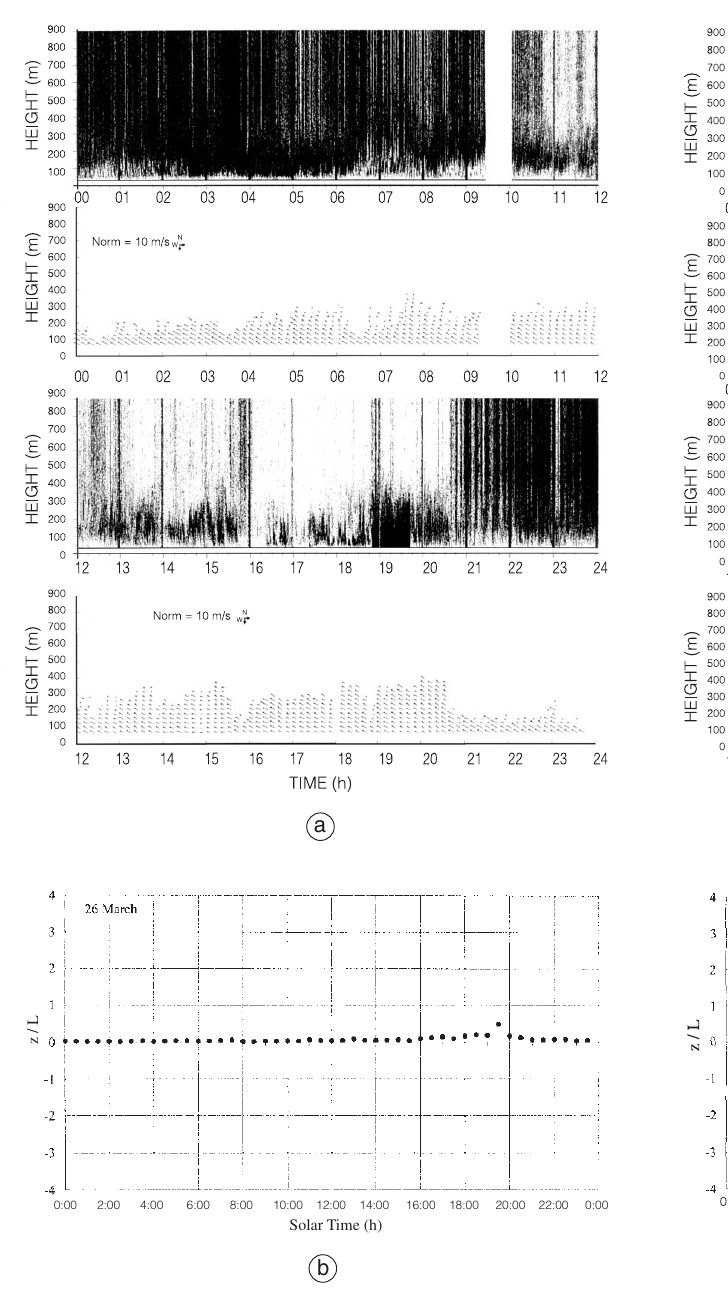
Fig. 7a,b. a) Sodar facsimile and horizontal velocity recorded at Ny-Ålesund on April 7, 1998 showing a stable layer with waves; b) stability parameter z/L as a function of solar